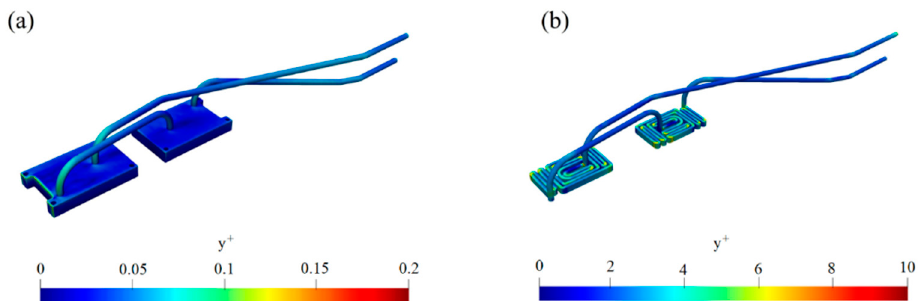
Figure 11. Distributions of the y + on the wall boundaries of ( a ) air and ( b ) water regions.